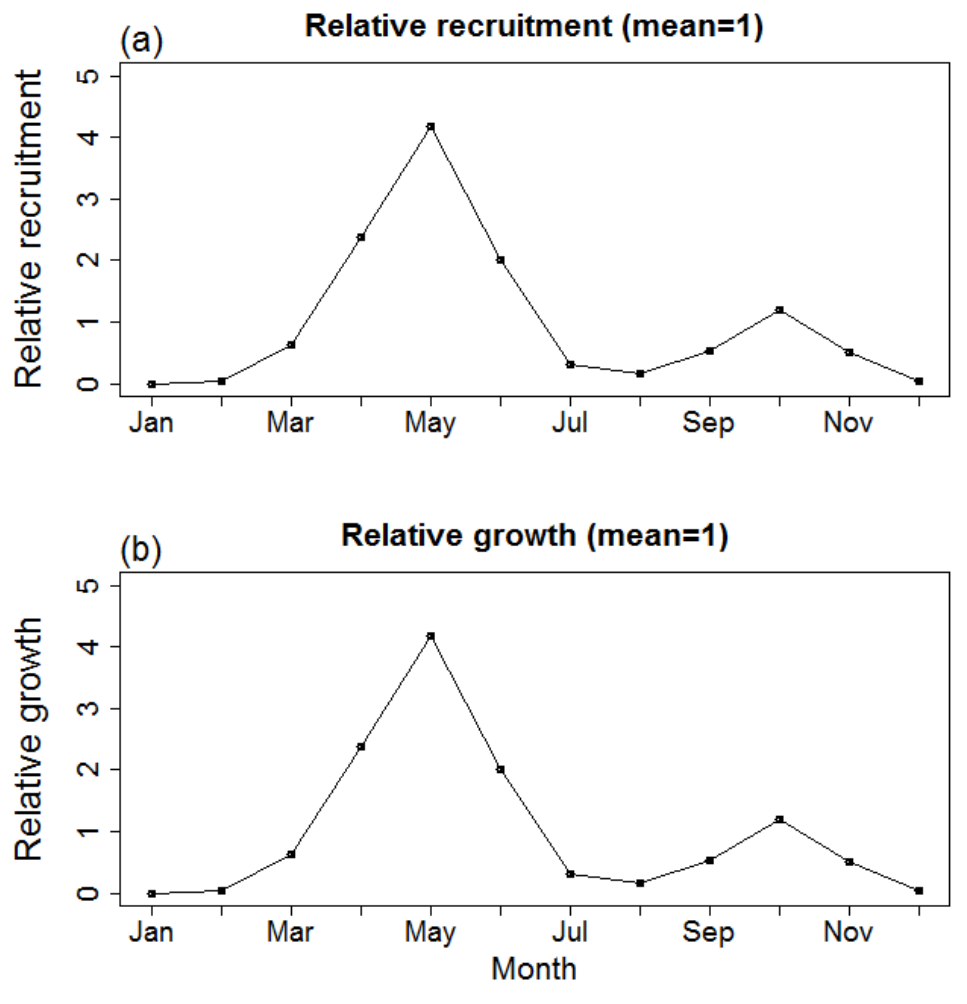
Figure A2.1. Monthly relative recruitment (a) and growth patterns (b) assumed for oysters in Apalachicola Bay, Florida based on empirical assessment of growth patterns and literature